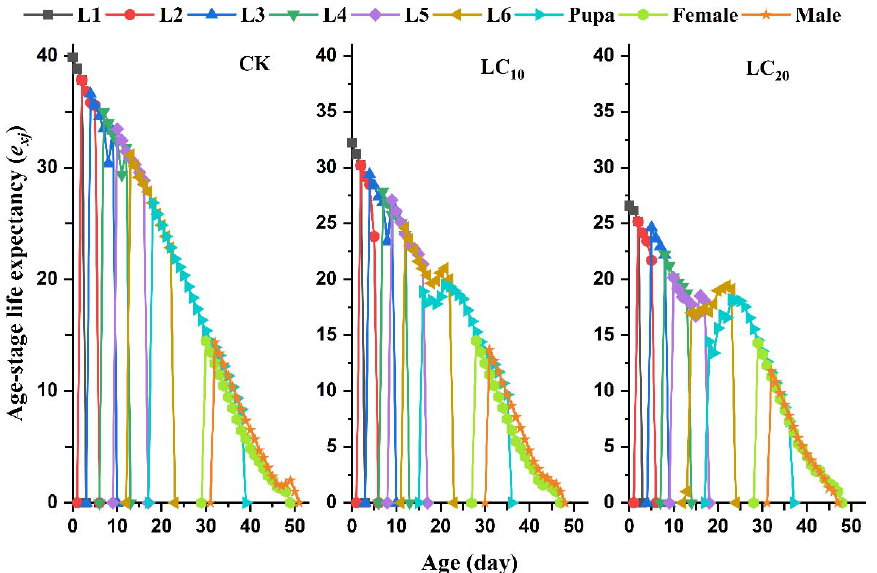
Figure 3. Age-specific life expectancy ( e xy ) of the immature and adult FAW offspring generation from the FAW parental generation exposed to sublethal concentrations (LC 10 and LC 20 ).